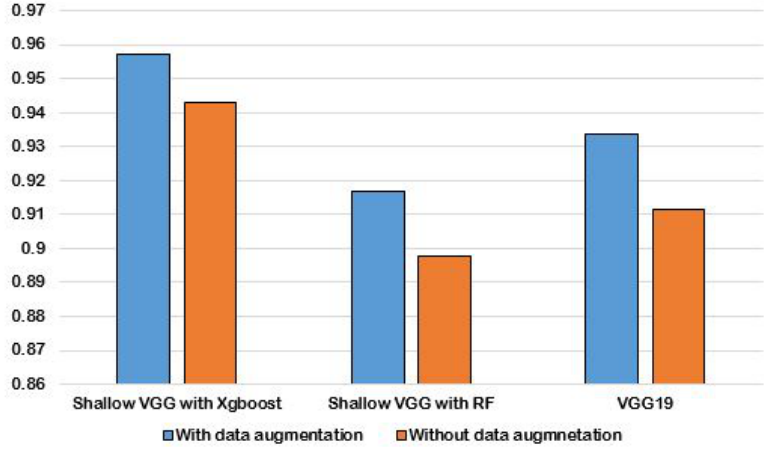
Figure 13. Mean accuracy on augmented and non augmented dataset.